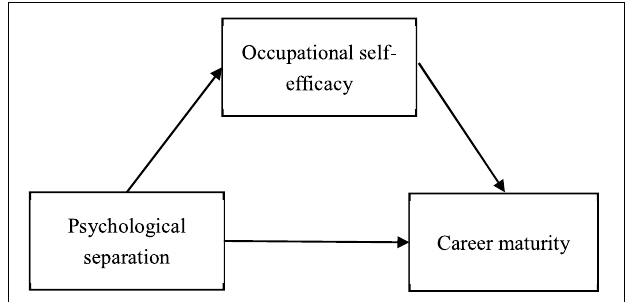
FIGURE 1 | Hypothetical model of the relationship between psychological separation and career maturity with occupational self-efficacy as an intermediary variable.